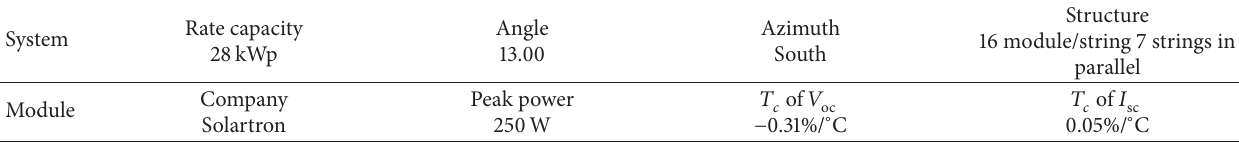
Table 3: The information of the PV system.